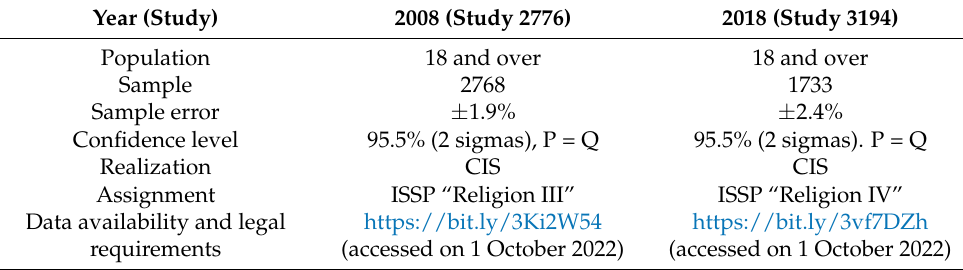
Table 1. Fact sheets of the